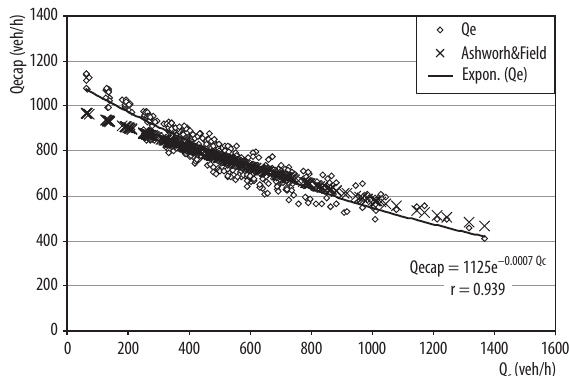
Fig. 3. Results of regression analysis and comparison of Ashworth & Field method